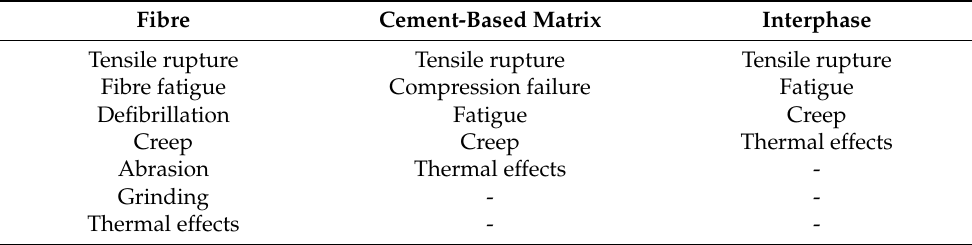
Table 2. Experimentally specified deterioration